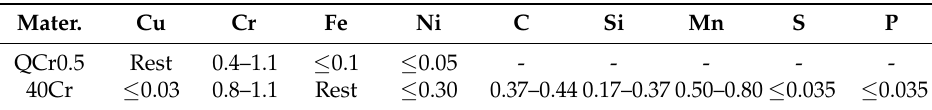
Table 1. Chemical compositions of the two